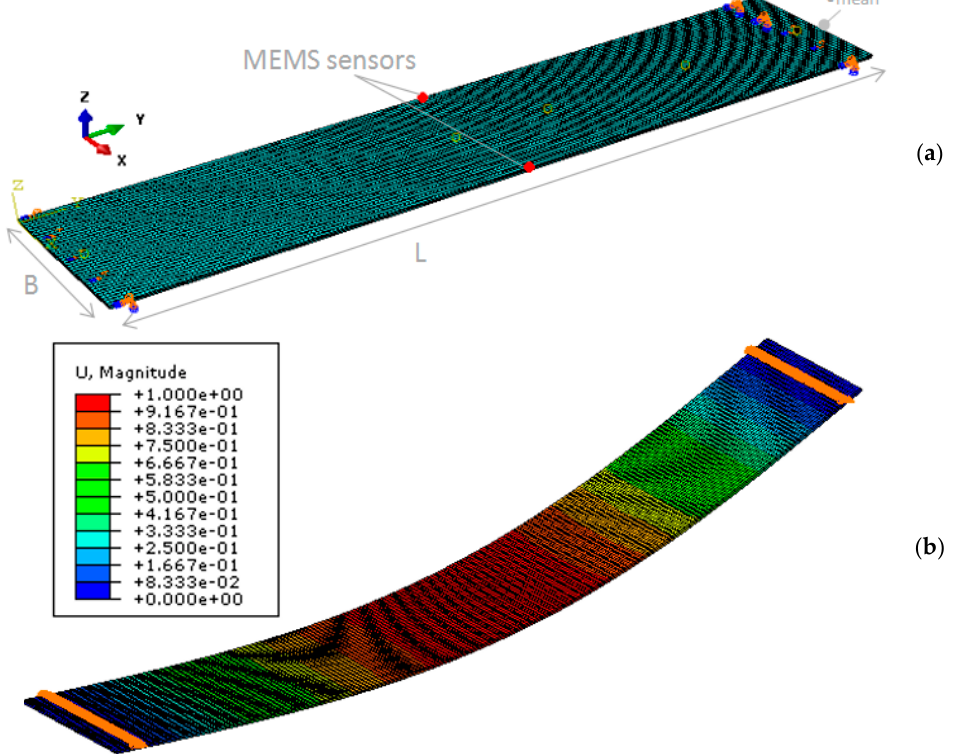
Figure 6. Numerically derived fundamental frequency for the tested glass specimens (ABAQUS): ( a ) typical FE model and ( b ) normalized vibration shape (example referred to a B-1 sample with “rigid” steel supports).